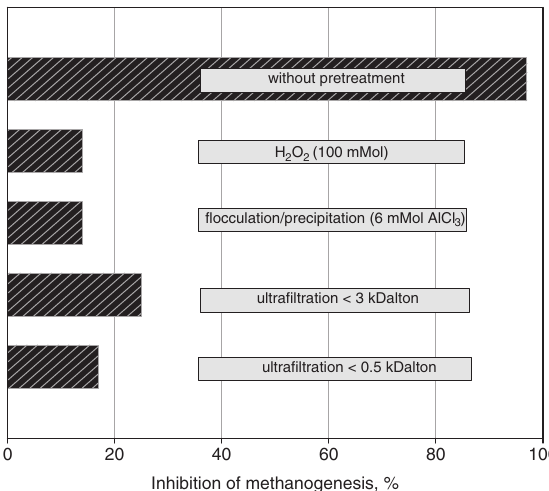
Fig. 4. Relative inhibition of methane formation of an acetoclastic methanogenic enrichment culture after different pre-treatments of water from a depth of 24 m of the